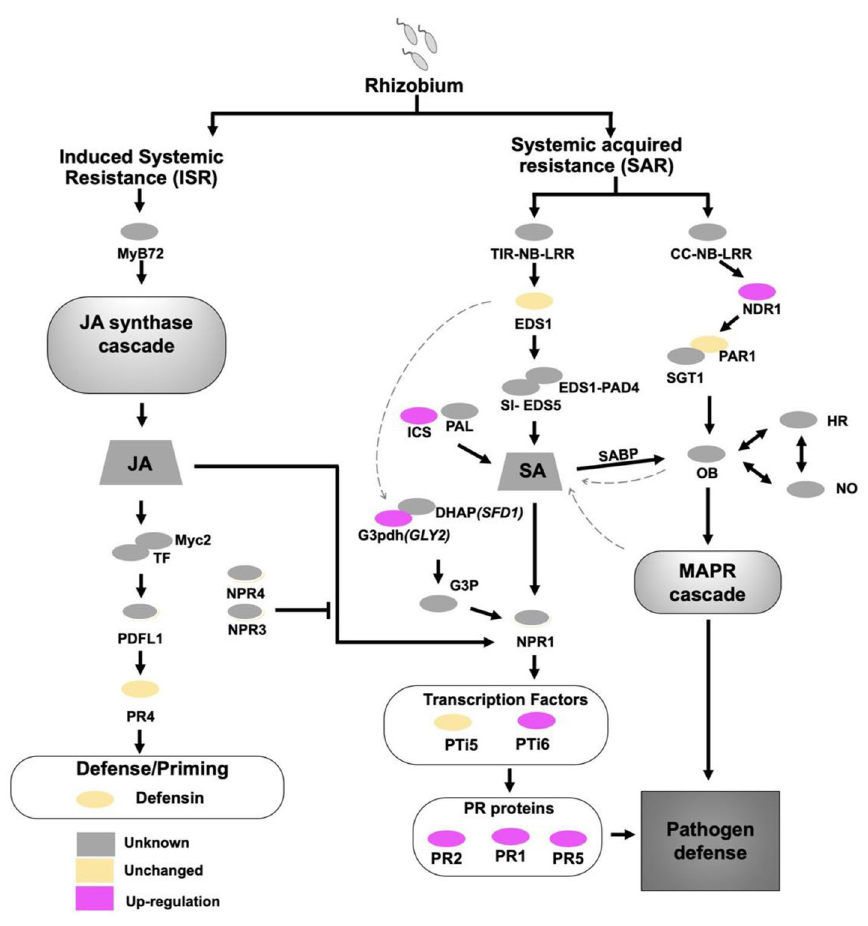
Figure 5. A schematic representation of how salicylic acid triggered the plant immune pathway in Vigna radiata cv. KPS1. This representation is based on the gene expression (qRT-PCR) comparison between USDA110 and 110nopE1E2 inoculation: grey colour (unknown), yellow colour (the gene expression was not different between USDA110 and 110nopE1E2 inoculation), and pink colour (the gene expression of 110nopE1E2 inoculation was significantly higher than that of USDA110 inoculation). Significance at P < 0.05 is indicated by the means ± standard deviations (n =